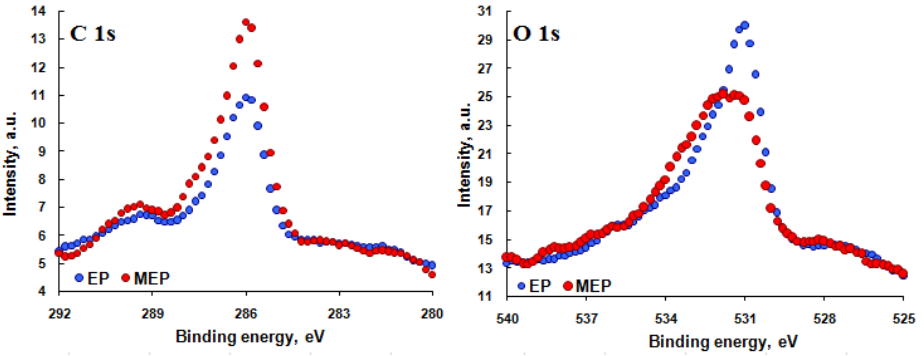
Figure 5. XPS high resolution C 1s and O 1s spectra of TNZ alloy sample surfaces after EP and MEP.